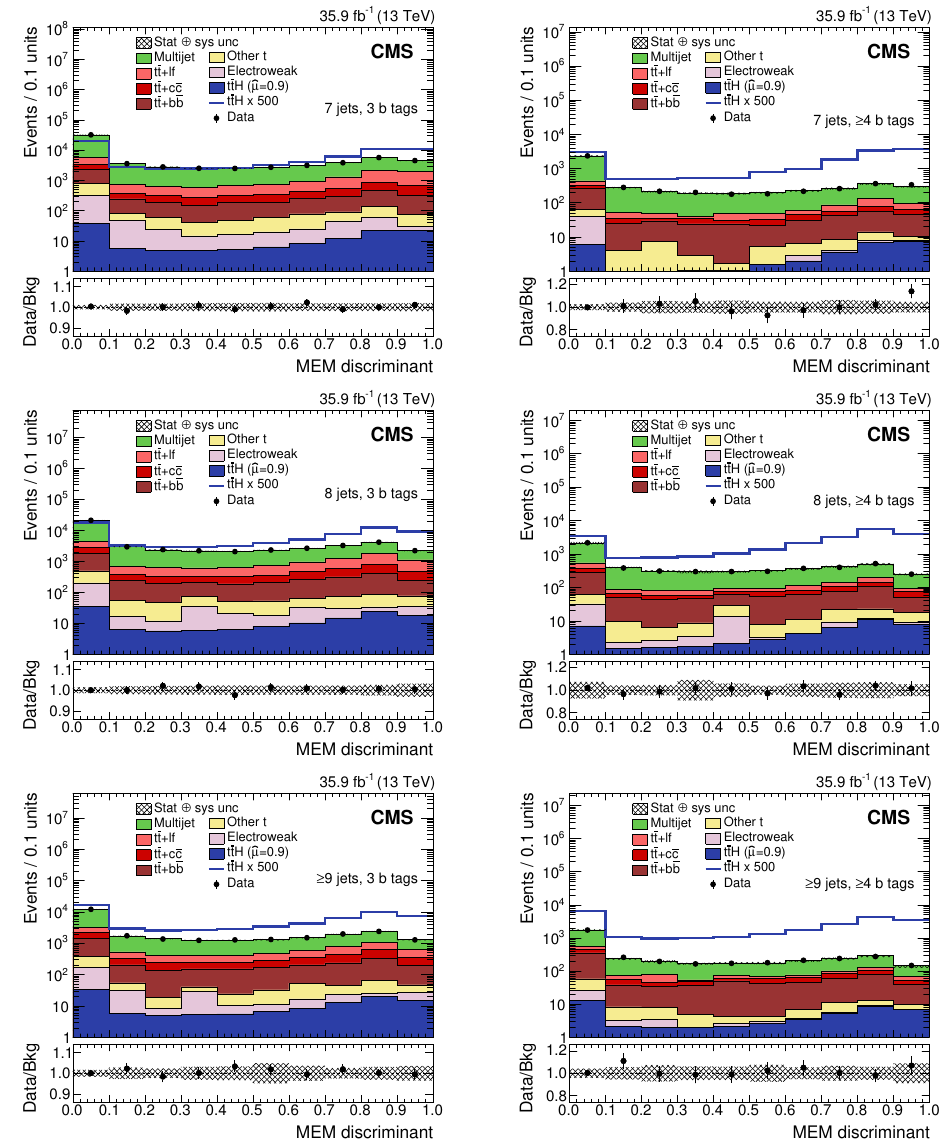
Figure 6 . Distributions in the (cid:12)tted MEM discriminant for each analysis category. The contri- butions expected from signal and background processes ((cid:12)lled histograms) are shown stacked. The tt+b and tt+2b background process are shown combined with tt+bb, the single t and tt+V pro- cesses are shown combined as \Other t", and the V+jets and diboson processes are shown combined as \Electroweak". The signal distributions (lines) for a Higgs boson mass of m H = 125 GeV are multiplied by a factor of 500 and superimposed on the data. The distributions in data are indicated by the black points. The ratios of data to background appear below the main